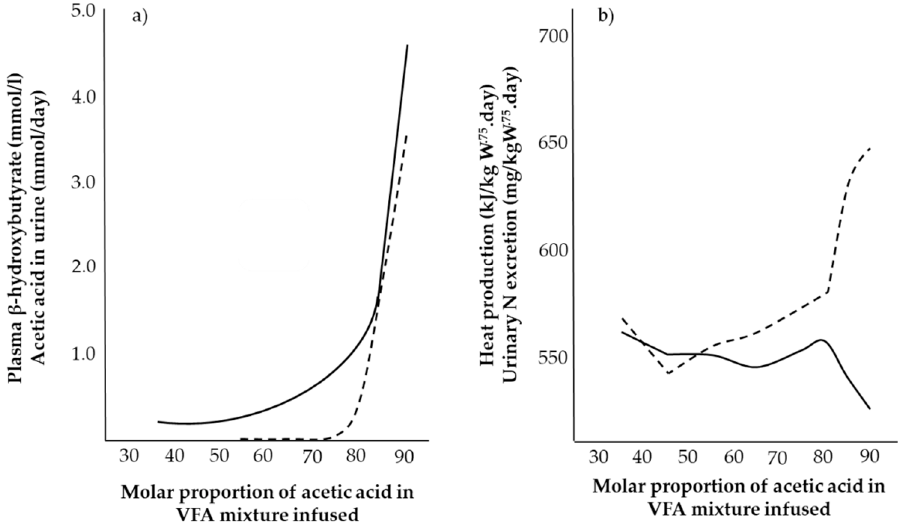
Figure 2. Effect of volatile fatty acid composition on ( a ) β -hydroxybutyrate (solid line) and acetic acid (dashed line) in urine, and ( b ) on heat production (solid line) and urinary N excretion (dashed line) of four steers. Adapted with permission from [17].